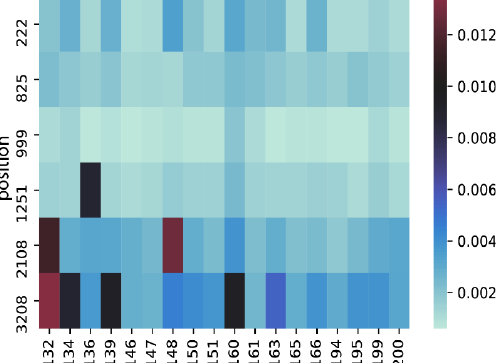
Figure 4. Heatmap of the subconsensus variant frequencies (SVF) in six diversity positions. SVF are displayed as colours ranging from blue to dark red. SVF was <1% in six positions in all samples, except for two positions in two samples (2108: #132 (SVF = 1.1%), #148 (SVF = 1.3%); 3208: #132 (SVF = 1.3%)).